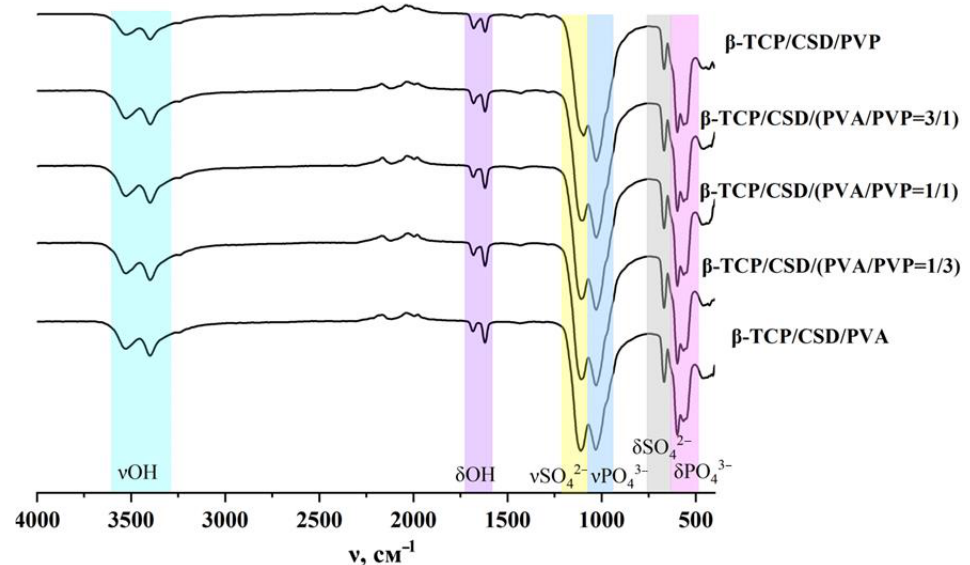
Figure 5. IR spectra of composite cement materials.